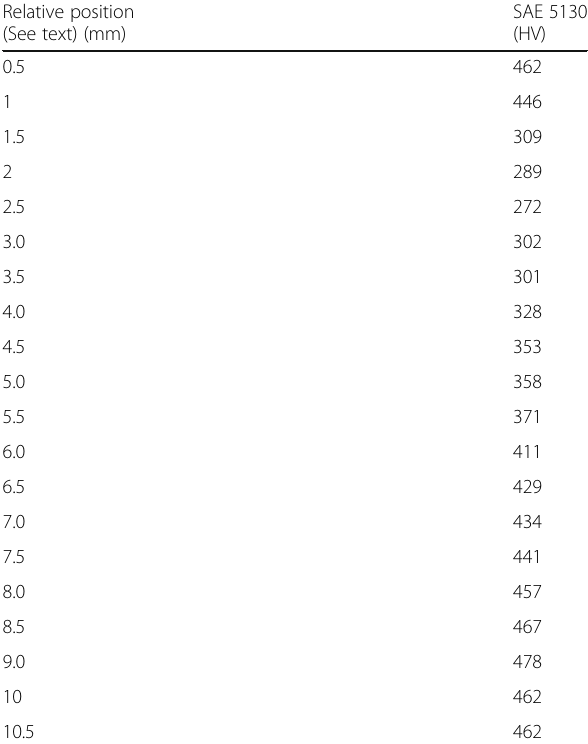
Table 2 Microhardness profile measured in treated steel SAE 5130 post-torching Relative position (See text) (mm)